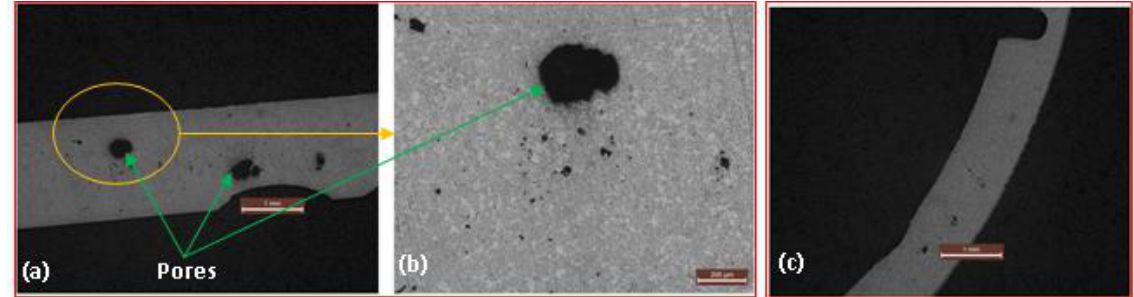
Figure 12: Optical microstructure of connector 2 for longitudinal (a, b) and transverse I sections in different magnifications. Un-etched.